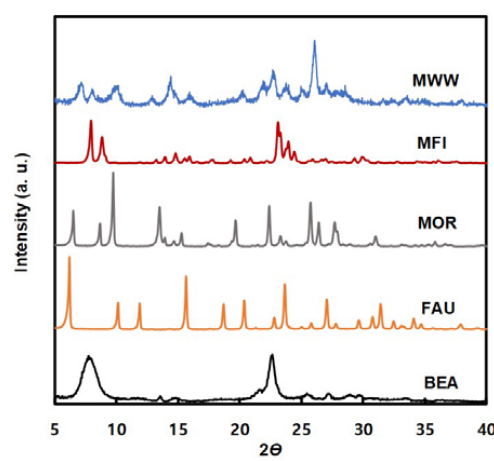
Figure 1. XRD patterns of the MWW, BEA, MOR, FAU, and MFI zeolites.